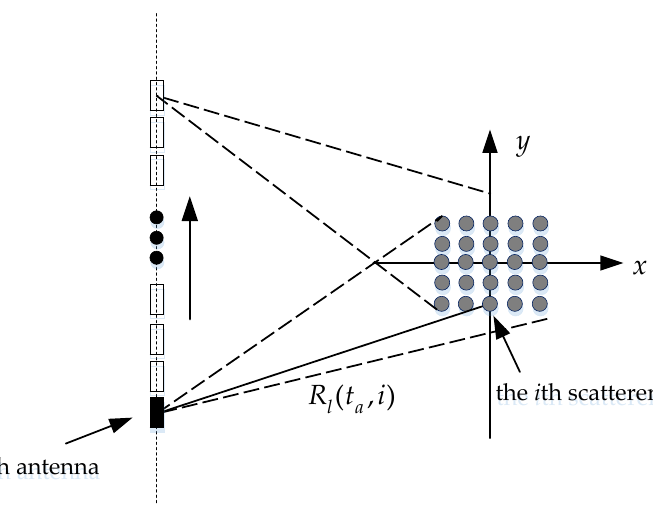
Figure 1. Geometry model for multichannel SAR imaging.